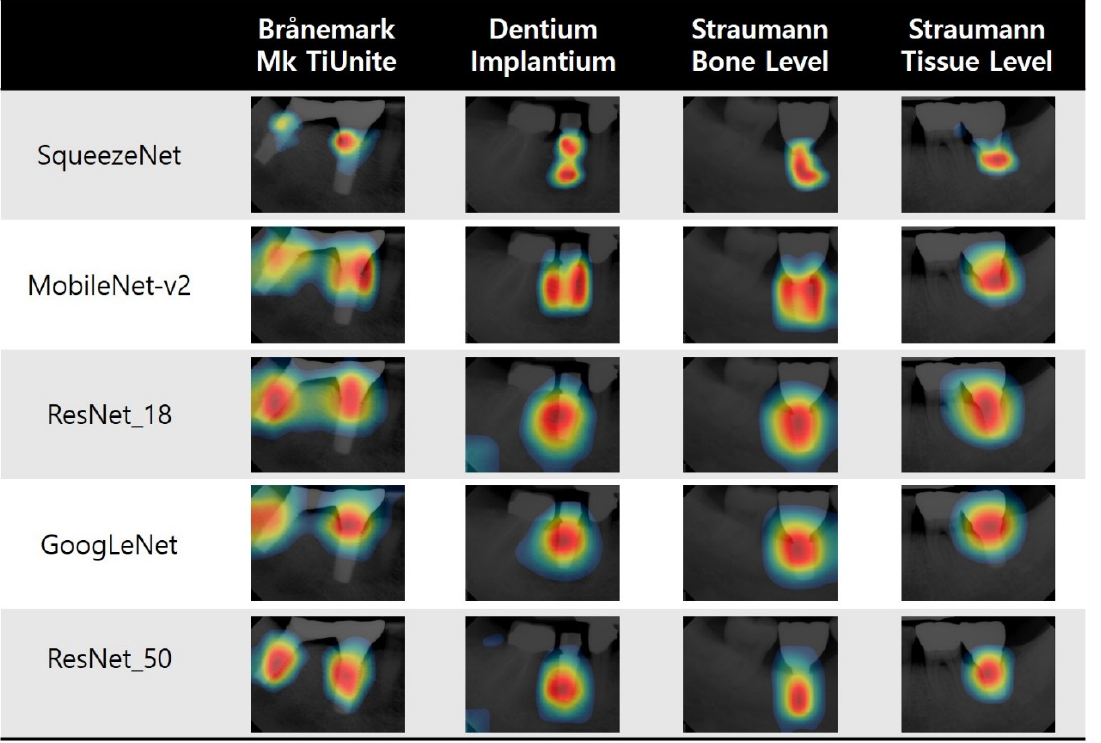
Figure 6. Example of the class activation maps of the five pretrained networks for the four selected implant fixture types.